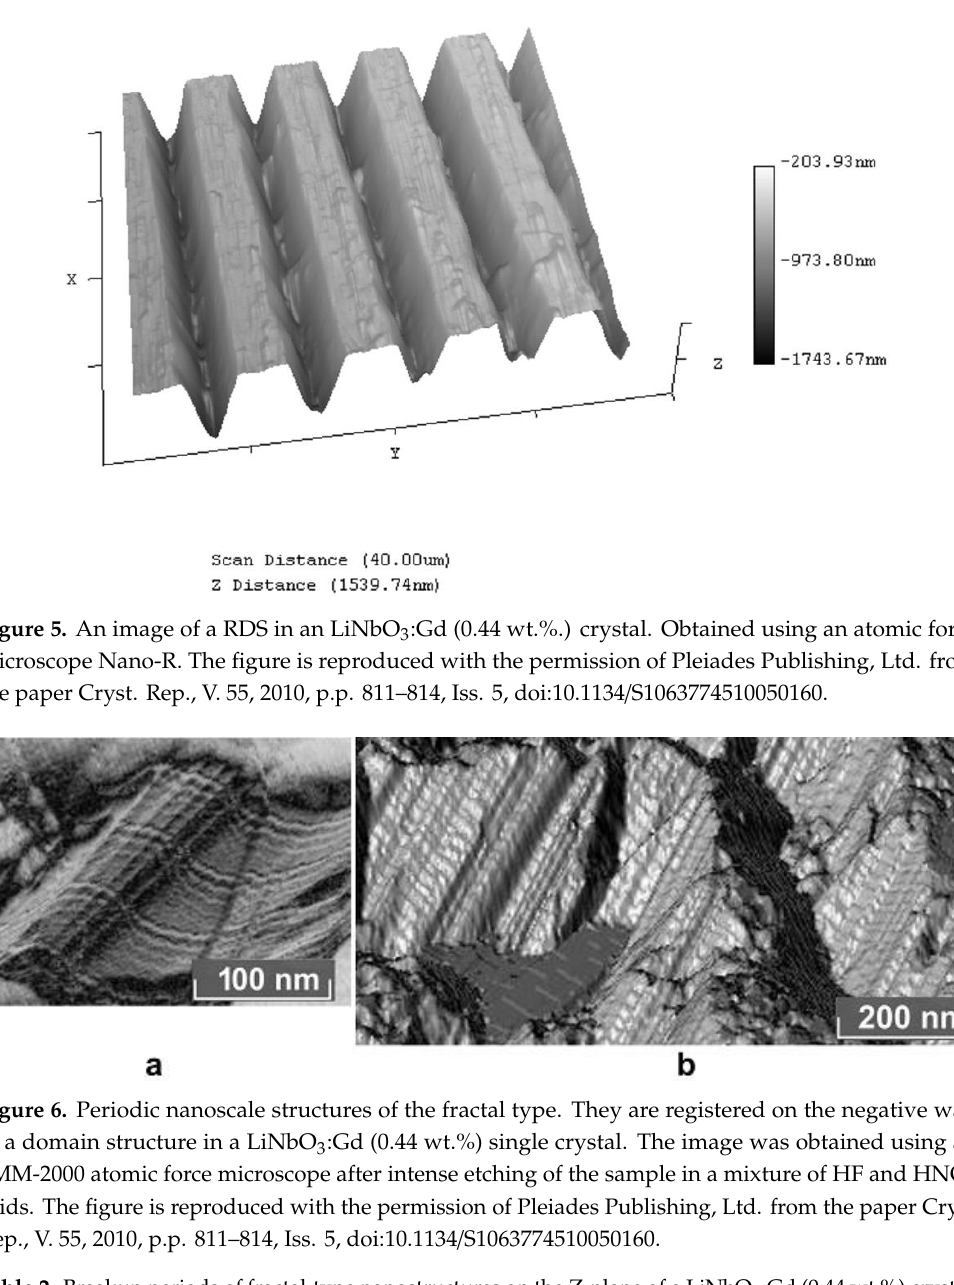
Table 2. Breakup periods of fractal-type nanostructures on the Z-plane of a LiNbO 3 :Gd (0.44 wt.%) crystal. The